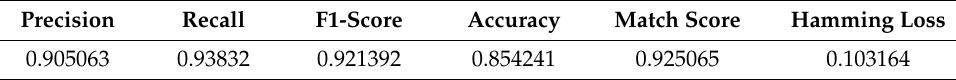
Table 11. The Results of Ground Truth